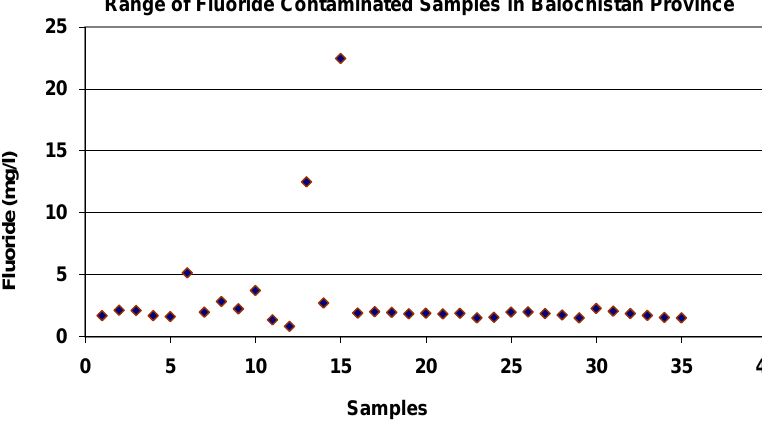
Figure-5: Range of fluoride contaminated samples (>1.5mg/l) in Balochistan Province Figure 5. Range of fluoride-contaminated samples ( > 1.5mgL − 1 ) in Balochistan